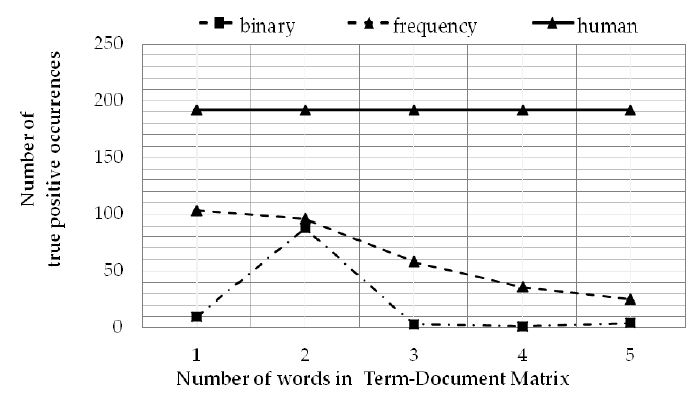
Figure 9 . LSA processing results (number of true positive occurrences) of the binary method and the frequency method using the normal distribution.